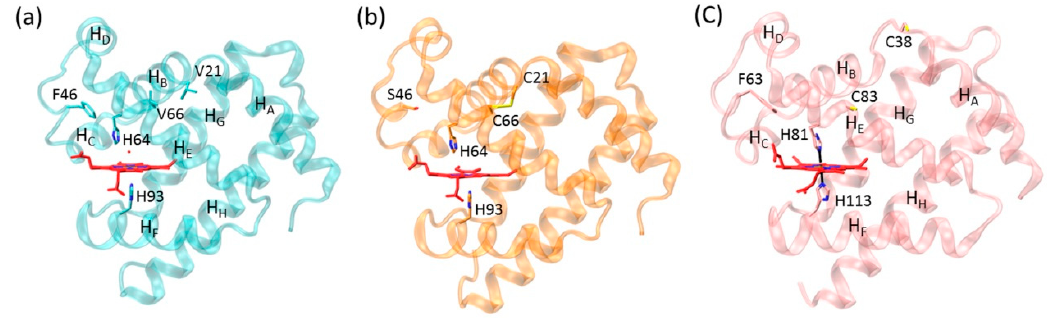
Figure 1. X-ray structure of ( a ) sperm whale Mb (PDB code 1JP6 [31] ), ( b ) F46S/V21C/V66C Mb mutant (PDB code 5ZEO [33]), and ( c ) human Cgb (PDB code 1V5H [27]) in their ferric forms. The proximal and distal His residues, the engineered disulfide bond of C21-C66, the reduced residues of C38 and C83, and the eight α -helices (H A -H H ) of Mb and Cgb are highlighted.